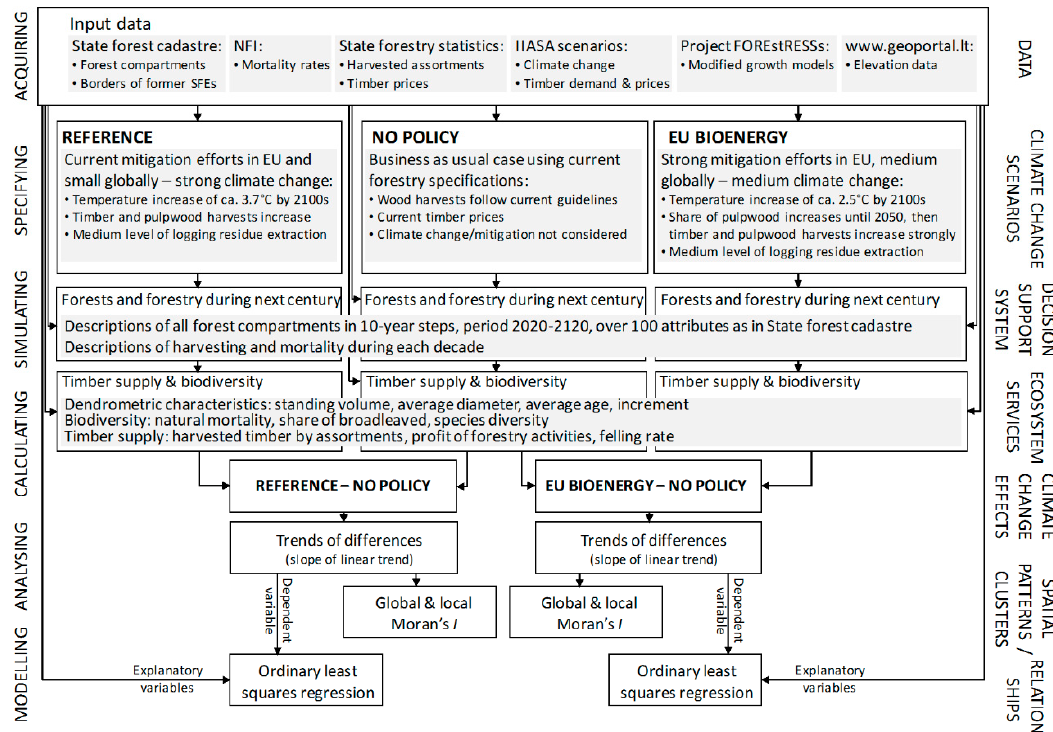
Figure 3. Flowchart summarizing the overall structure of the study.